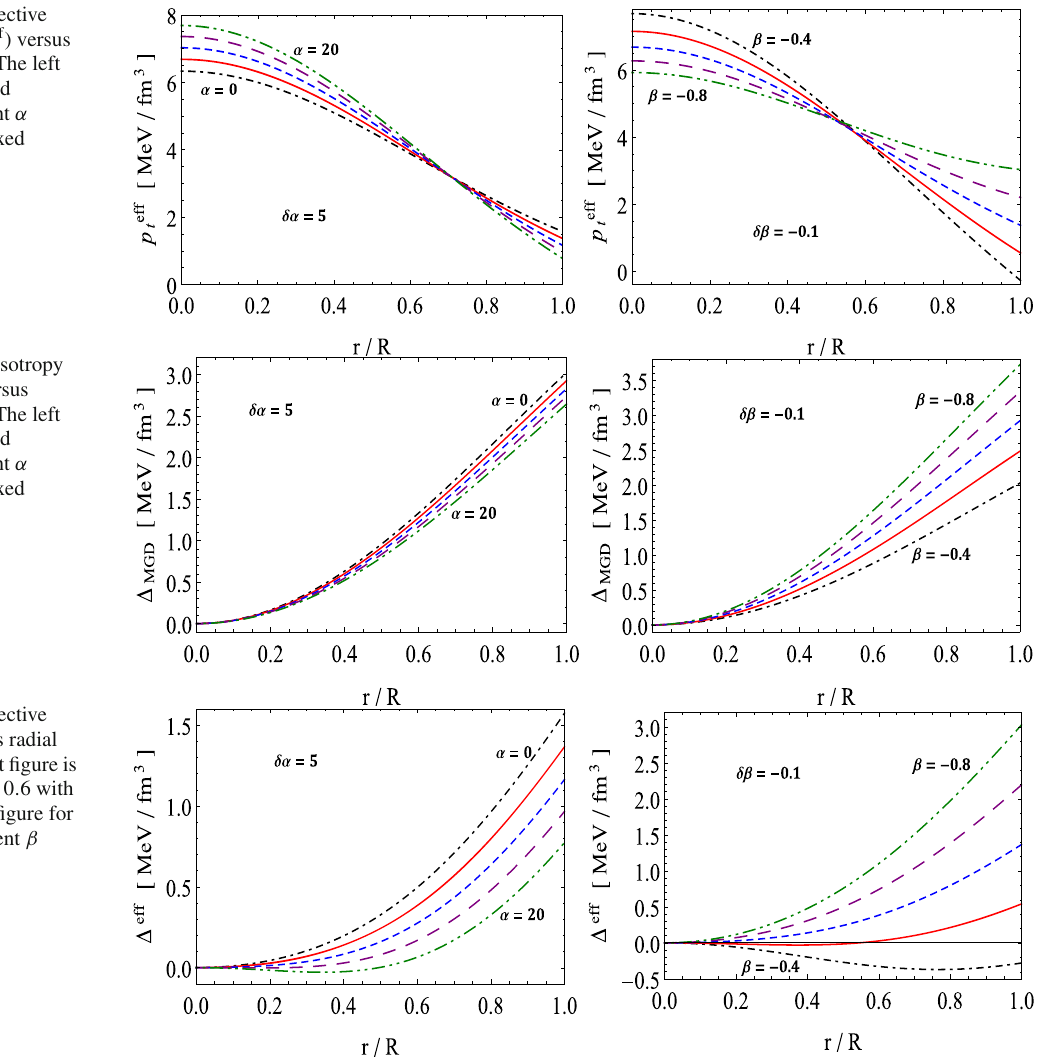
Fig. 5 Variation of anisotropy contribution (cid:17) MGD versus radial coordinate r / R . The left figure is plotted for fixed β = − 0 . 6 with different α while right figure for fixed α = 5 with different β